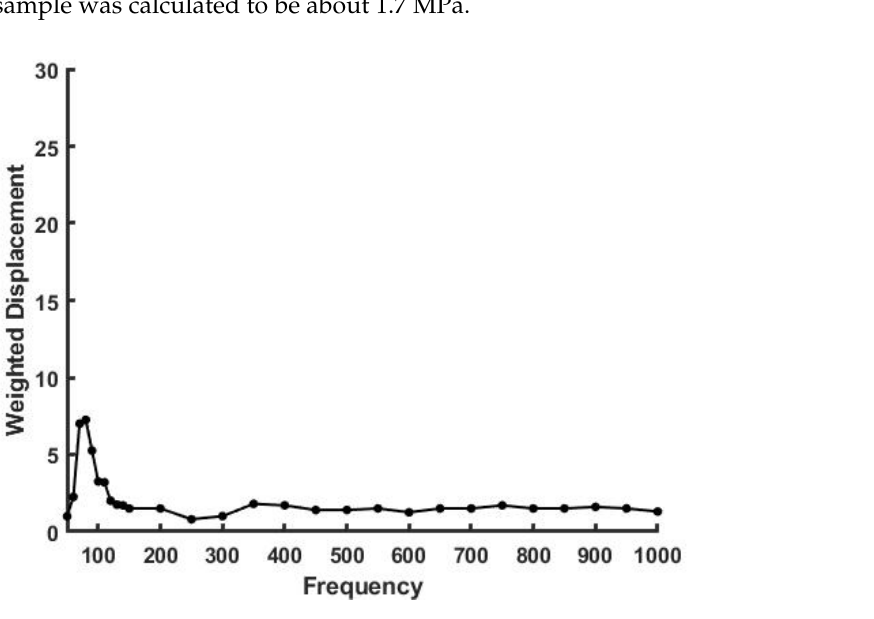
Figure 3. Weighted displacement in μ m vs. frequency in Hz for silicone rubber. Note the presence of a single peak at 120 Hz suggesting that the material is monodisperse. The modulus of this sample is 1.7 MPa.